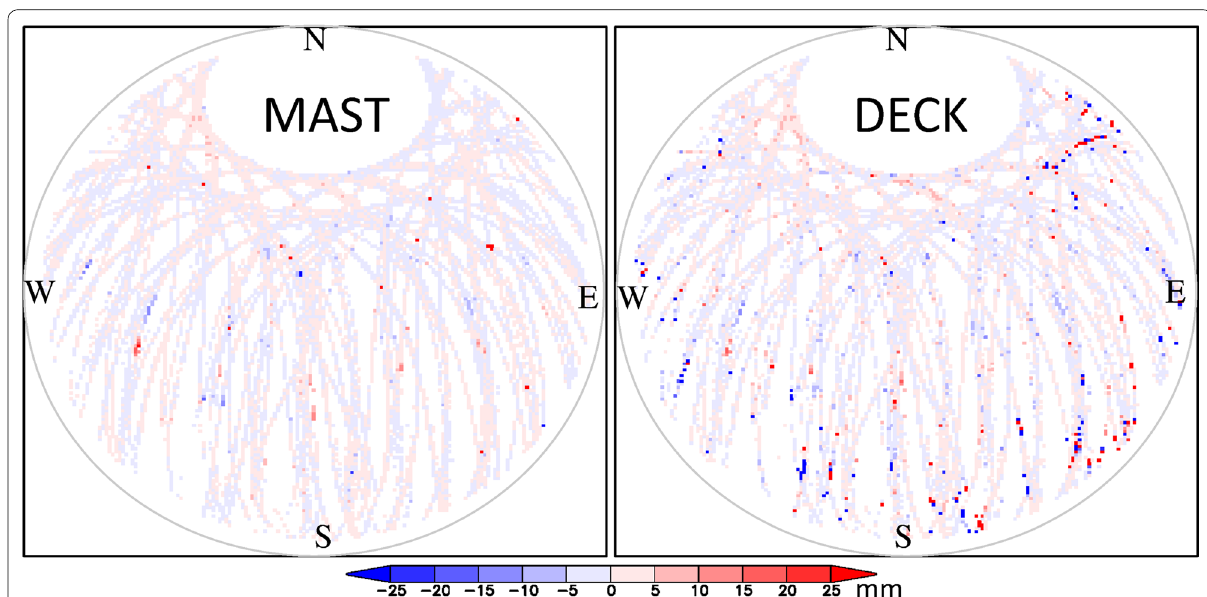
Fig. 3 Sky plots of the time-averaged post-fit phase residual of the averaged L3 ionosphere-free linear combination, while the RYOFU MARU was anchored at its home port (Daiba, Tokyo)